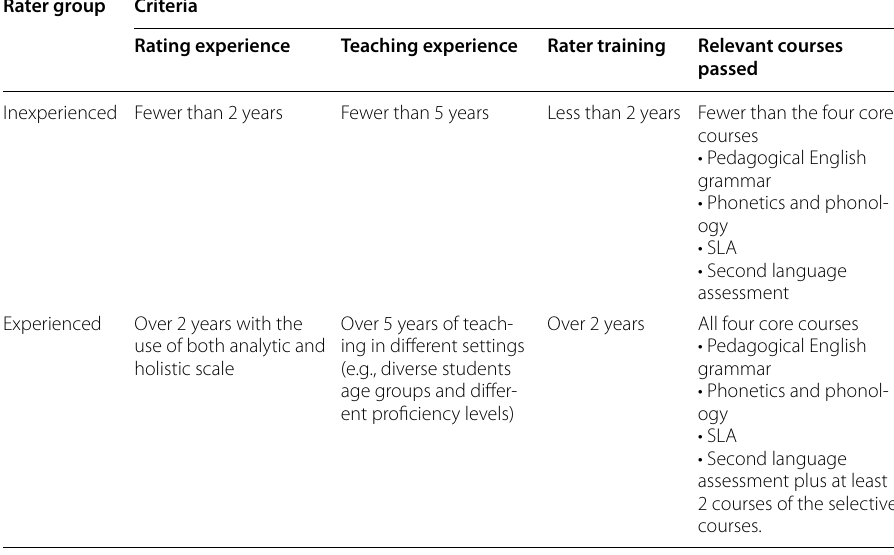
Table 2 Criteria for rating expertise Rater group